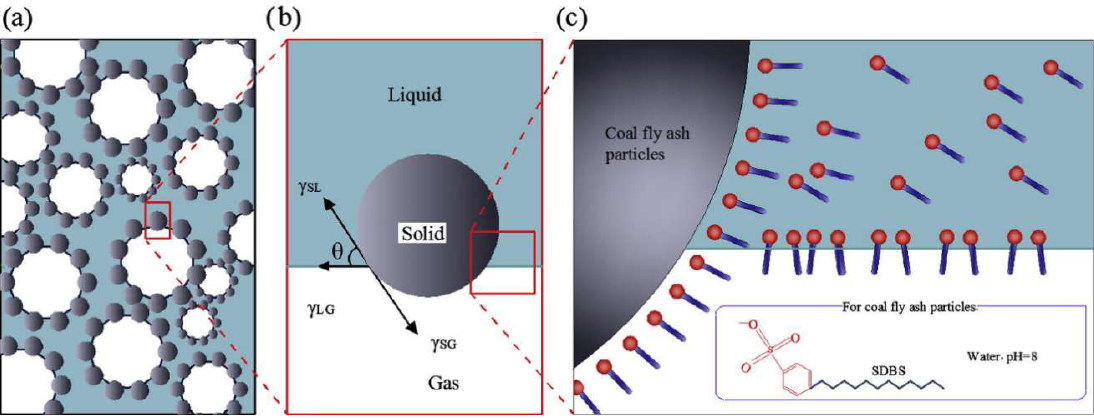
Figure 15. A structure model of three-phase foam to attach fly ash (FA) particles at the N2-water interfaces by tuning their surface-wetting properties: ( a ) Schematic illustration of the stabilization of gas bubbles with fly ash particles; ( b ) the adsorption of partially lyophobic FA particles at the gas–liquid interface, illustrating the balance in tension responsible for the attachment of particles; ( c ) a possible approach used to tune the wetting properties of originally hydrophilic particles by the absorbed sodium dodecyl benzene sulfonate (SDBS) molecules [63].